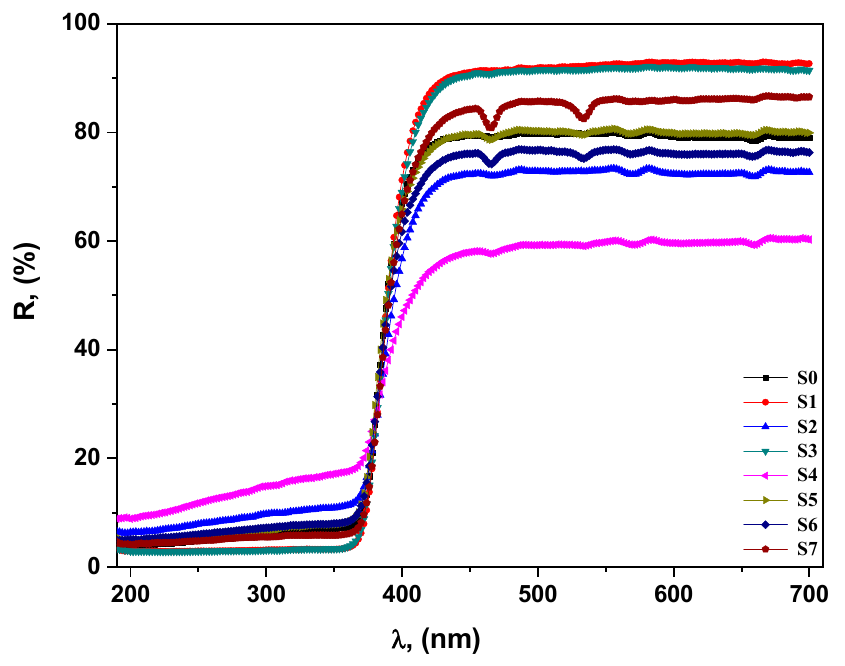
Figure 4. Graph of the optical diffused reflectance (ODR) of all nanostructured Eu 2 O 3 -ZnO samples with different doping ratios of europium versus light wavelength.